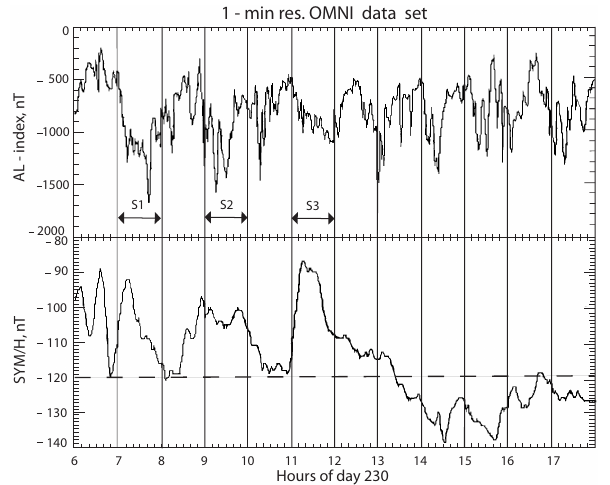
Figure 8. Geomagnetic indices AL (nT) and SYM-H (nT) for the interval 06:00–18:00UT on 18 August 2003. Three sawtooth sub- storms during the interval 07:00–12:00UT are marked S1, S2, and